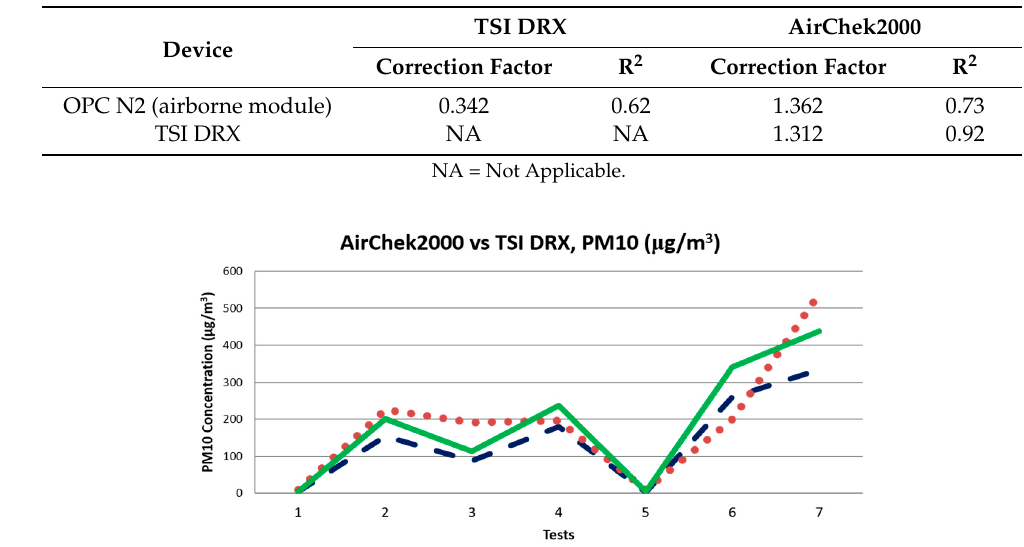
Table 1. Correction factors calculated with the analysis of the data from the dust chamber.